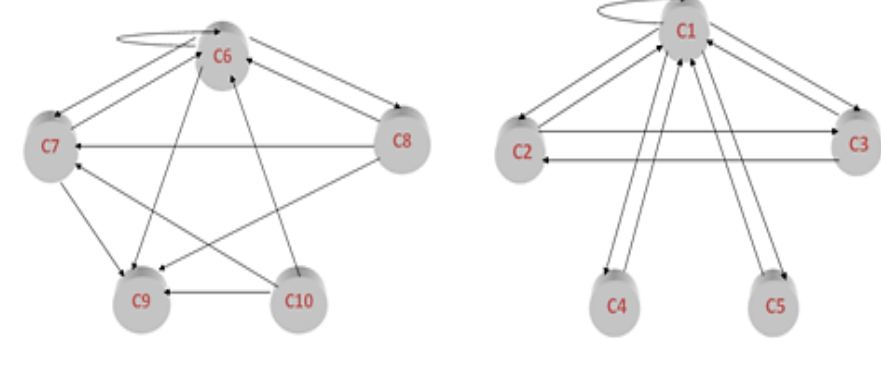
Fig. 3. Effects of criteria on each other.